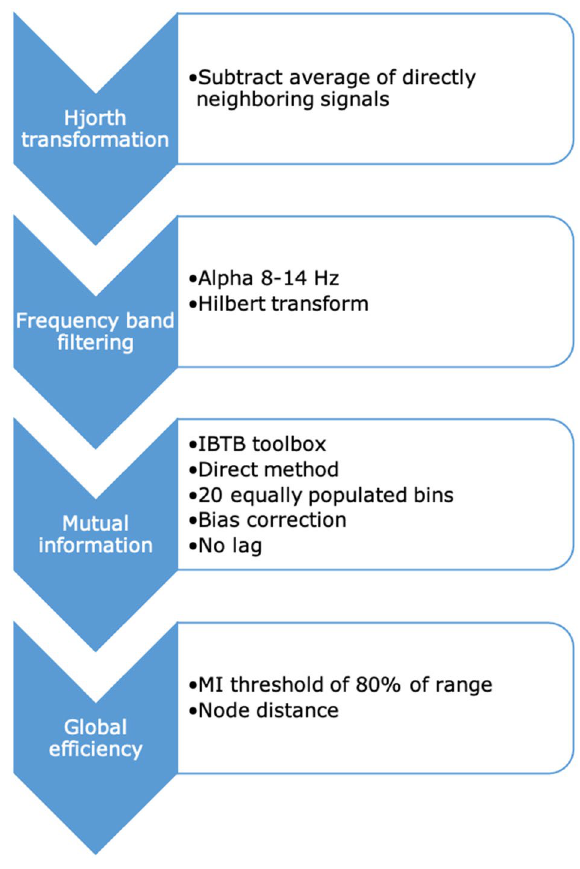
Figure 8. Flowchart of steps in the mutual information